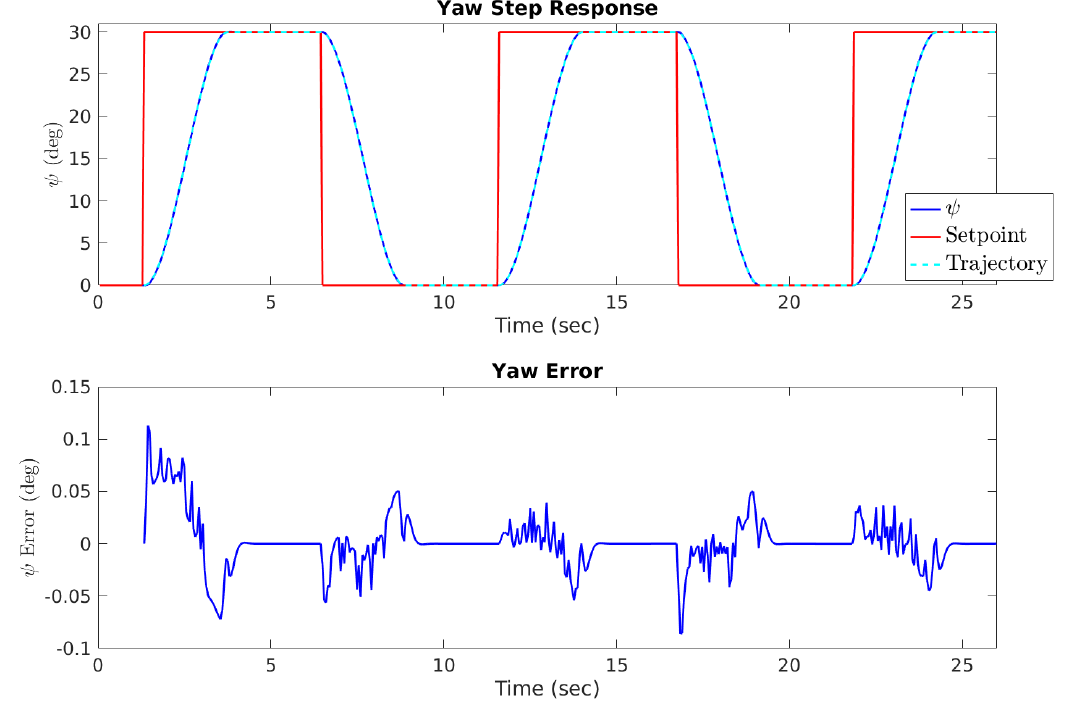
Figure 5. Yaw step response and the associated trajectory tracking